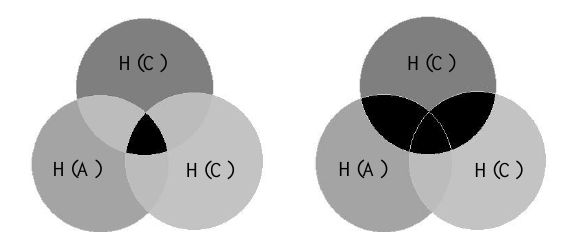
Figure 1. Venn diagram of multivariable (left) and Combined MI (right).